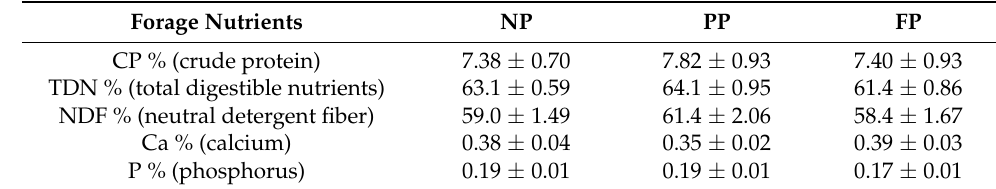
Table 5. Nutrients in pastures consumed by dams in the different groups (mean ± standard error of the